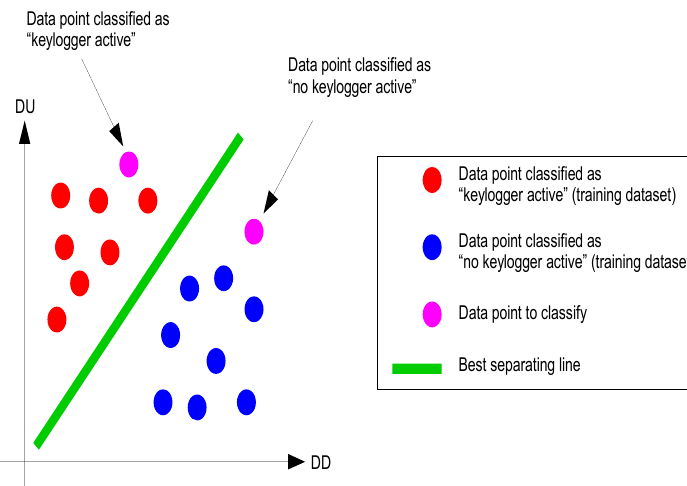
Figure 2. Keylogger detection by Support Vector